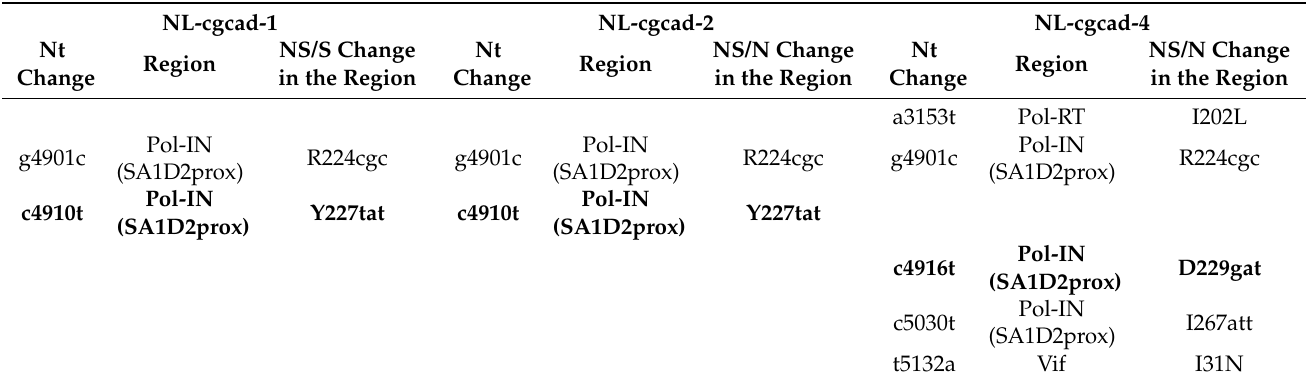
Figure 4. Characteristics of viral clones constructed from adapted NL-R224cgc. ( A ) Growth kinetics. Viruses prepared from HEK 293T cells transfected with the indicated pro-viral clones were inoculated into H9 cells (2 × 10 3 RT units/10 5 cells). Virus replication was monitored by the virion-associated RT activity in the culture supernatants. This experiment was performed once to select viral clones that have the ability to grow in cells. Viral replication kinetics of WT NL4-3 and a parental NL-R224cgc are presented in both panels for easy comparison. ( B ) Vif expression levels. Western blotting analysis was carried out as described in Figure 3B. Numbers correspond to those for the adapted clones shown in panel ( A ). Representative data from two independent experiments are shown. Short, short exposure; Long, long exposure. Table 3. Mutations found in adapted clones with decreased Vif expression levels compared to that in the NL-R224cgc